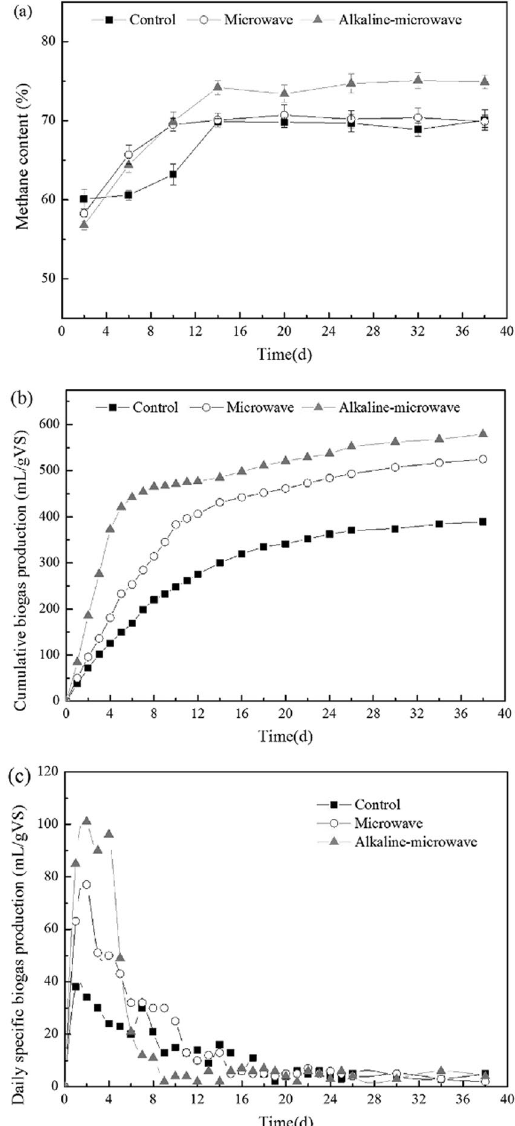
Figure 5. Methane content and cumulative biogas production of manure after different pretreatments. ( a ) Methane content; ( b ) Cumulative biogas production; ( c ) Daily specific